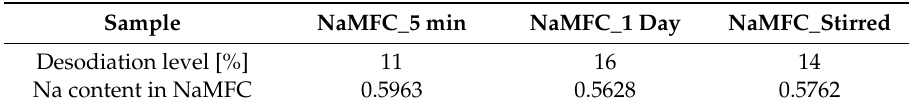
Table 2. Estimation by titration of the desodiation level from the pristine NaMFC (Na content at 0.67) with a precision of ±